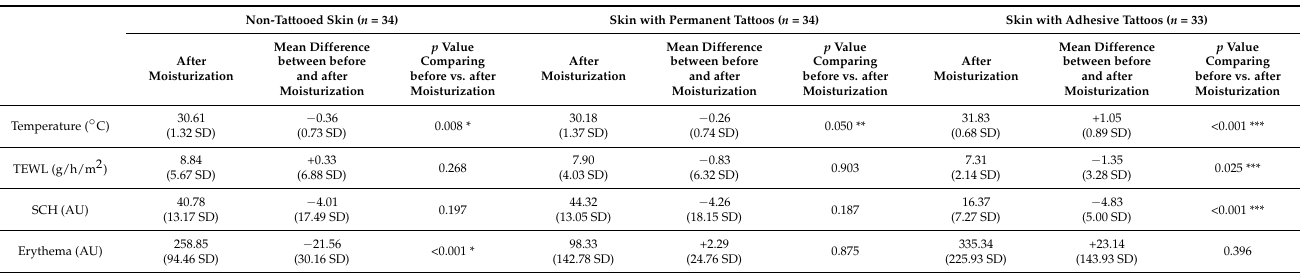
Table 5. Differences in biophysical parameters between moisturized skin and non-moisturized skin for non-tattooed skin, skin with permanent tattoos and skin with adhesive